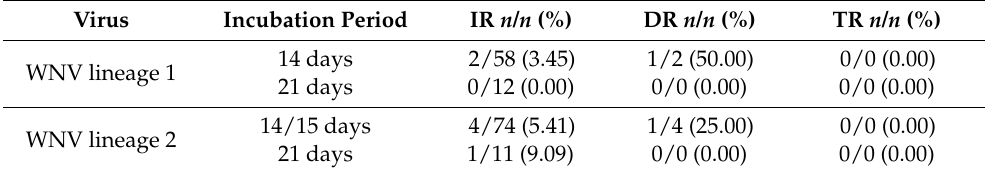
Table 1. Infection (IR), dissemination (DR) and transmission rates (TR) of Ae. punctor for WNV lineages 1 (strain Magpie/Italy/203204) and 2 (strain mosquito/Germany/T-166-60).